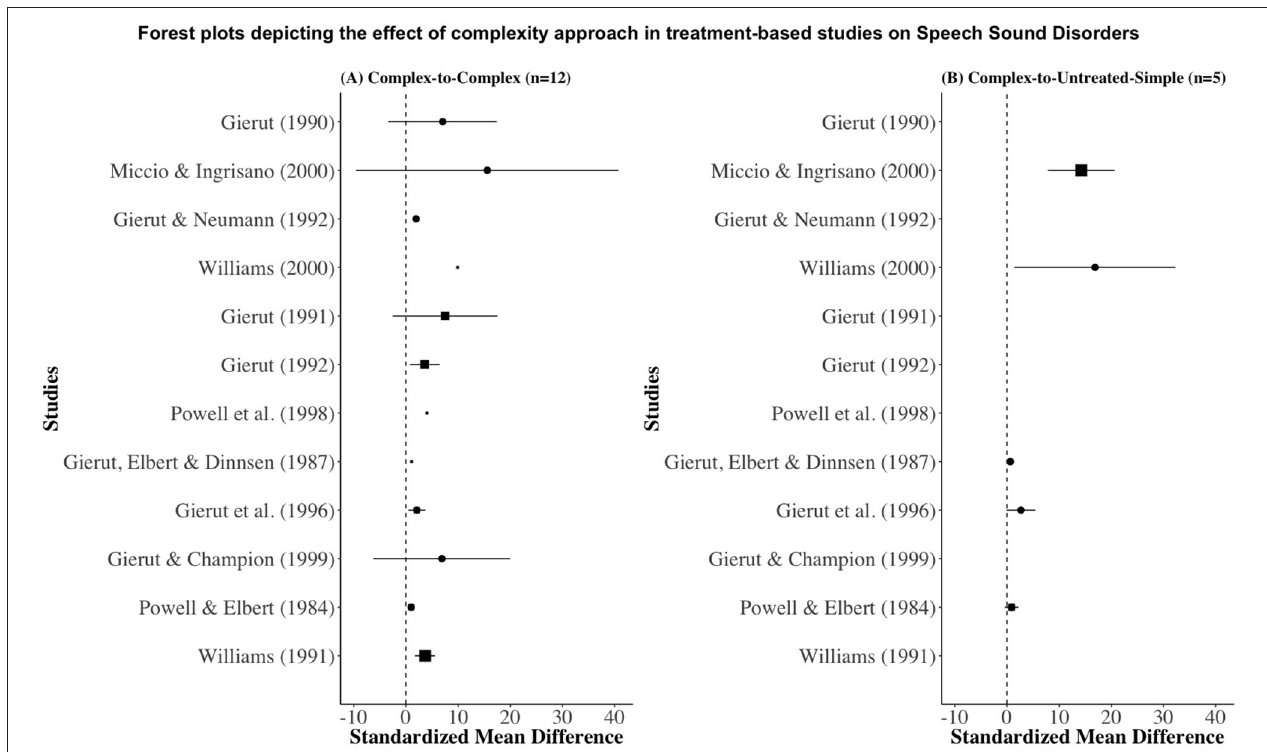
FIGURE 2 | Forest plots depicting the effect of complexity approach in treatment of speech sound disorders. (A) Effect of complexity approach on treated complex sounds; (B) Effect of complexity approach on untreated simple sounds.